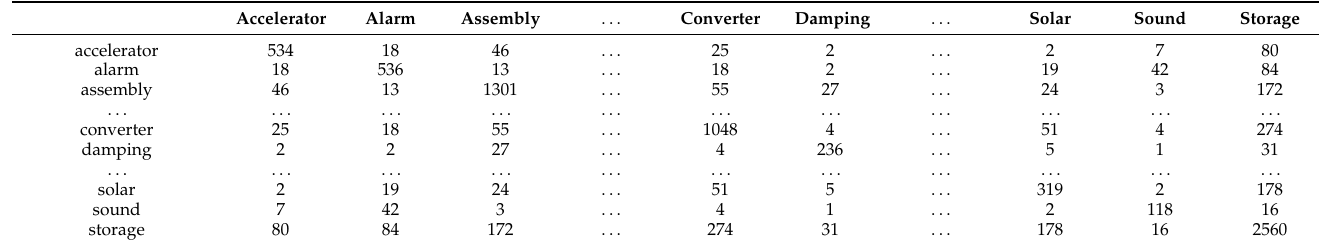
Table A1. Co-occurrence matrix for technical keywords in the EVs field in 2017.